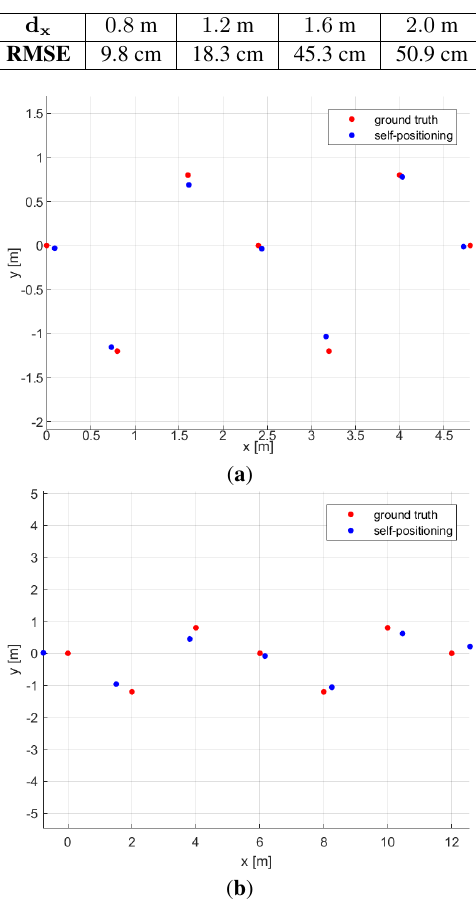
Table 1. UWB anchors self-positioning error (RMSE [cm])